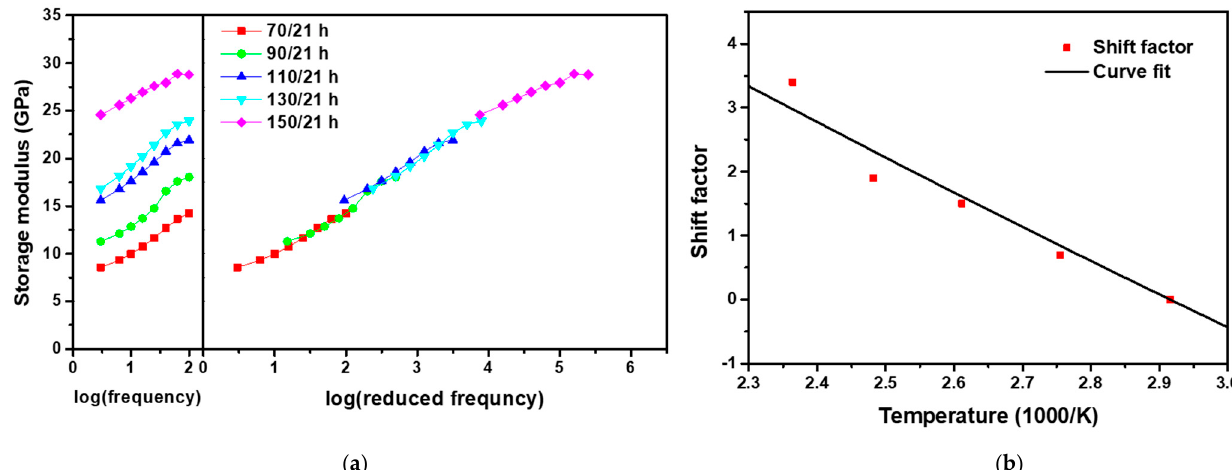
Figure 7. Thermomechanical behavior of LEO-exposed SMPCs. ( a ) Storage moduli measured as a function of frequency at a reference temperature of 70 °C (in DMA) and a master curve built at the reference temperature of 70 °C, and ( b ) shift factors for the master curve. Table 4. Thermomechanical properties for five validation datasets in a low-Earth orbit (LEO) envi- ronment.